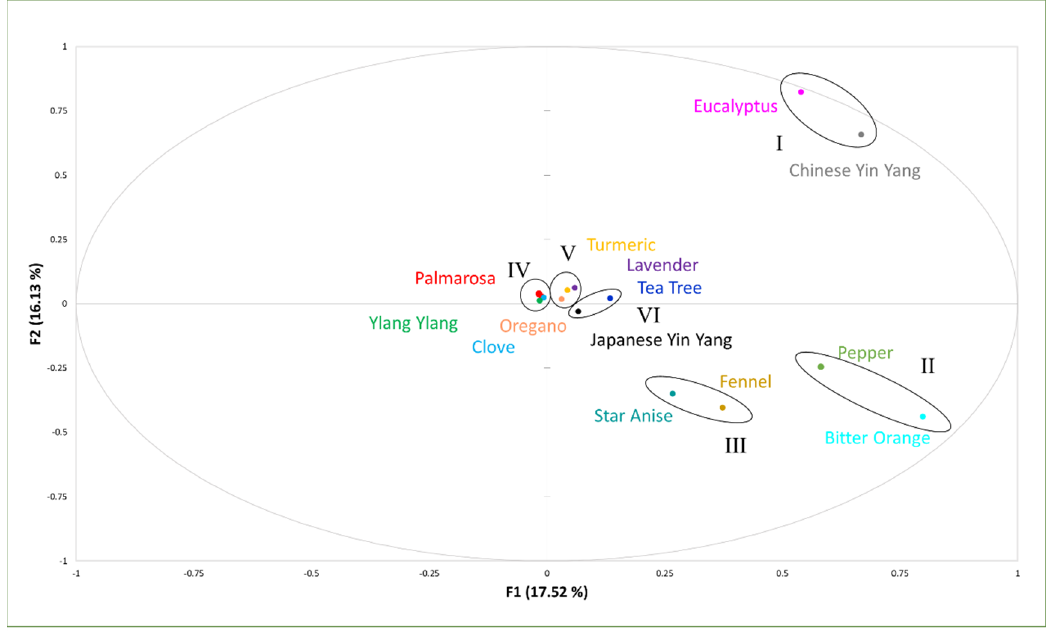
Figure 1. Principal component analysis (PCA) involving compositions of 14 EOs determined by gas-chromatography–mass spectrometry (GC–MS).